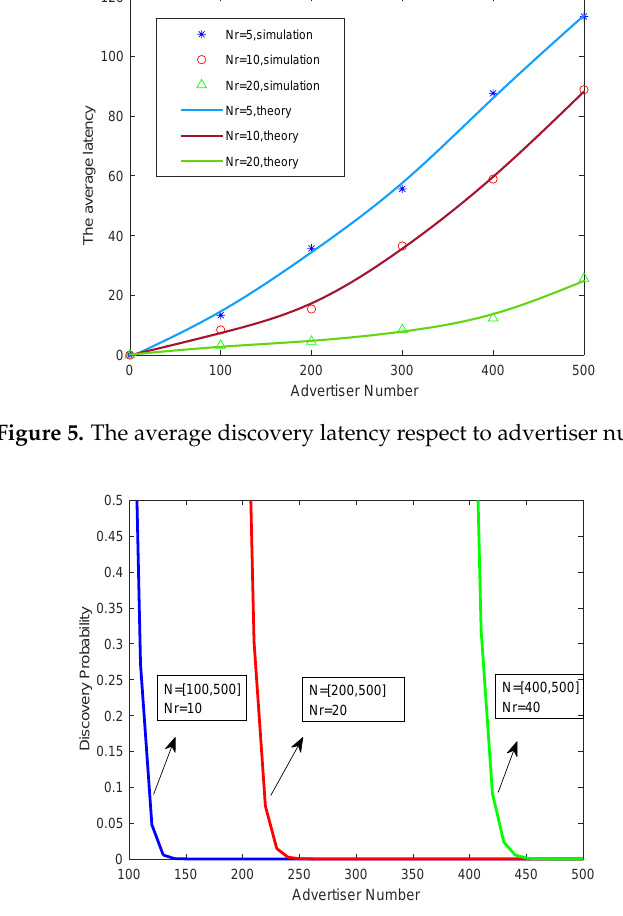
Figure 6. The discovery probability respect to advertiser numbers.